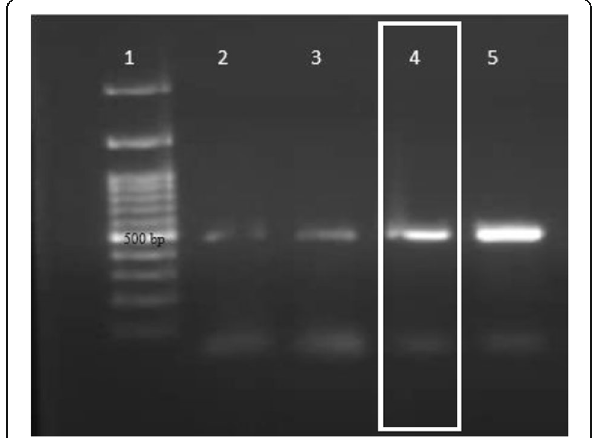
Fig. 10 Amplified DNA of the ITS-2 region of rDNA with specific primers: lane 1, 100-bp DNA markers; lane 2 to lane 5, Trichogramma sp. The size of the amplified ITS2 region of rDNA